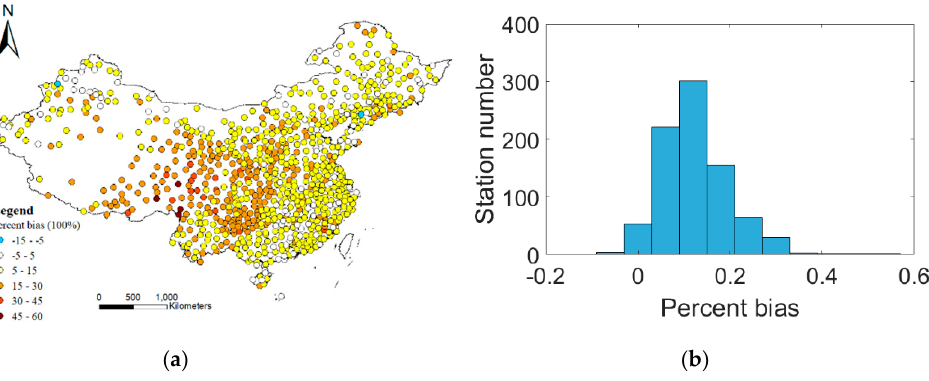
Figure 4. Spatial distribution of percentage bias, indicating the accuracy of average annual PET_cma values ( a ), and frequency distribution of percentage bias ( b ).